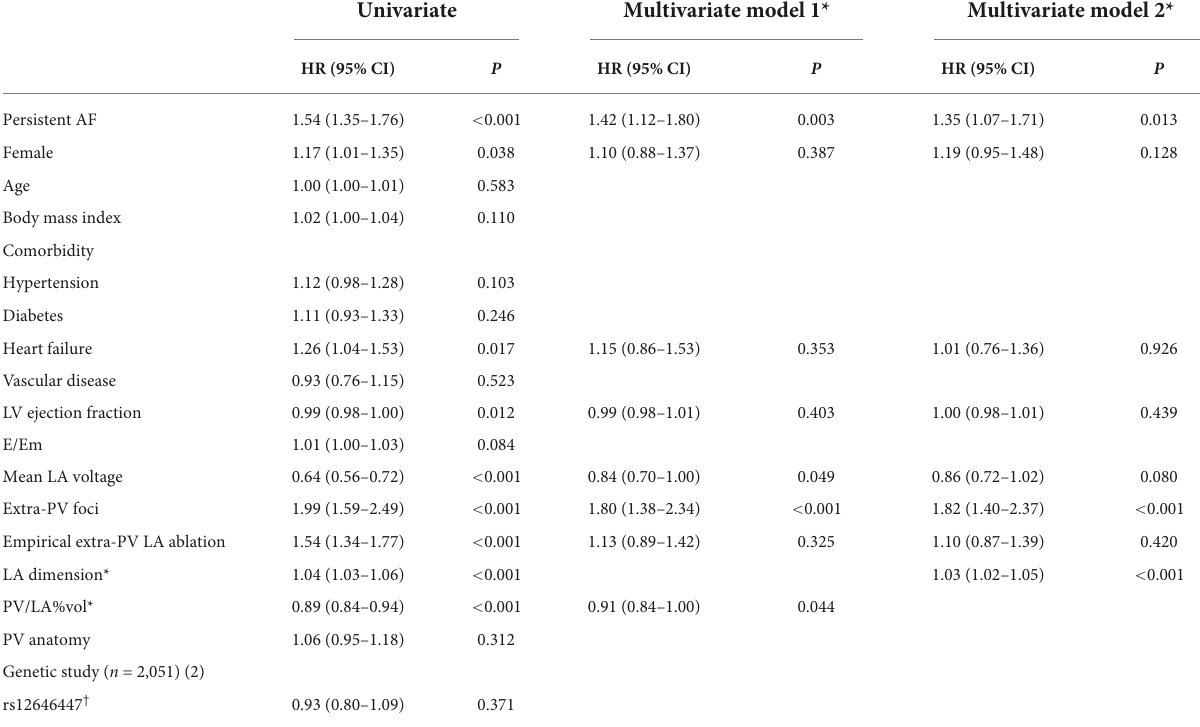
TABLE 4 Cox regression analysis for clinical recurrence after AFCA.